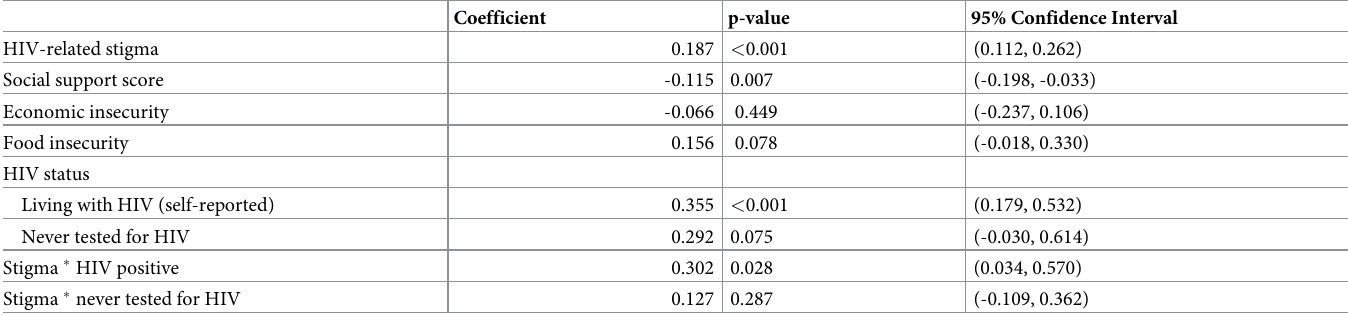
Table 4. Multivariable linear regression models for depressive symptoms by HIV status, HIV-stigma, and social support, (n = 761).